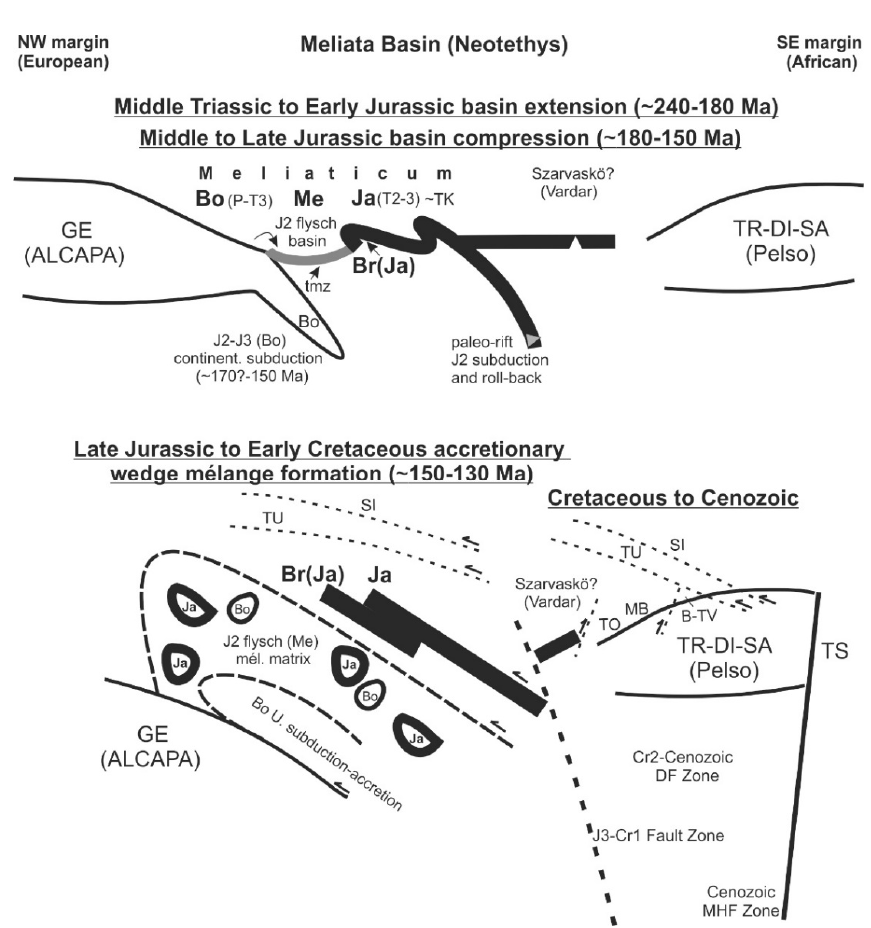
Figure 21. Paleotectonic zones and an outline of subduction–accretion structure of the Meliaticum (Meliata Superunit), not to scale. N–S distribution of the Triassic–Jurassic paleotectonic zones: GE—Gemericum (Gemeric Superunit—Early Paleozoic basement and Carboniferous–Lower Triassic